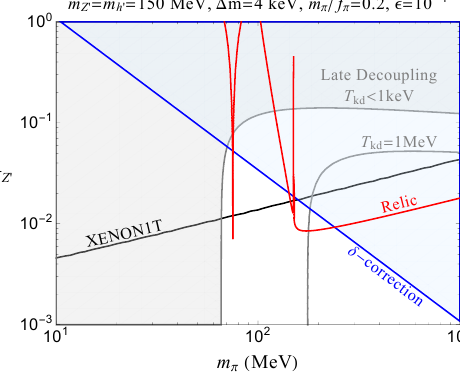
Figure 4 . Parameter space for explaining the XENON1T electron excess: ε vs m Z 0 (left in top), g Z 0 vs m ˜ π (right in top) and g Z 0 vs m ˜ π (bottom). The XENON1T electron excess can be explained along black line and the correct relic density is saturated along red line. The relic densities for heavier dark mesons are exponentially suppressed in gray region (line) due to late decoupling for T kd < 1 keV ( T kd = 1 MeV) , and the blue region is disfavored due to large Z 0 corrections to the mass splitting. The brown (purple) region is excluded by BaBar visible (invisible) searches, whereas yellow, pink, gray, green dashed and orange dashed lines are ruled out by NA64, Orsay, E137, SHiP (projected) and Belle-2 (projected), respectively. We have taken ∆ m = 4 keV and ¯ σ e /m χ = 1 . 2 × 10 − 43 cm 2 / GeV 1